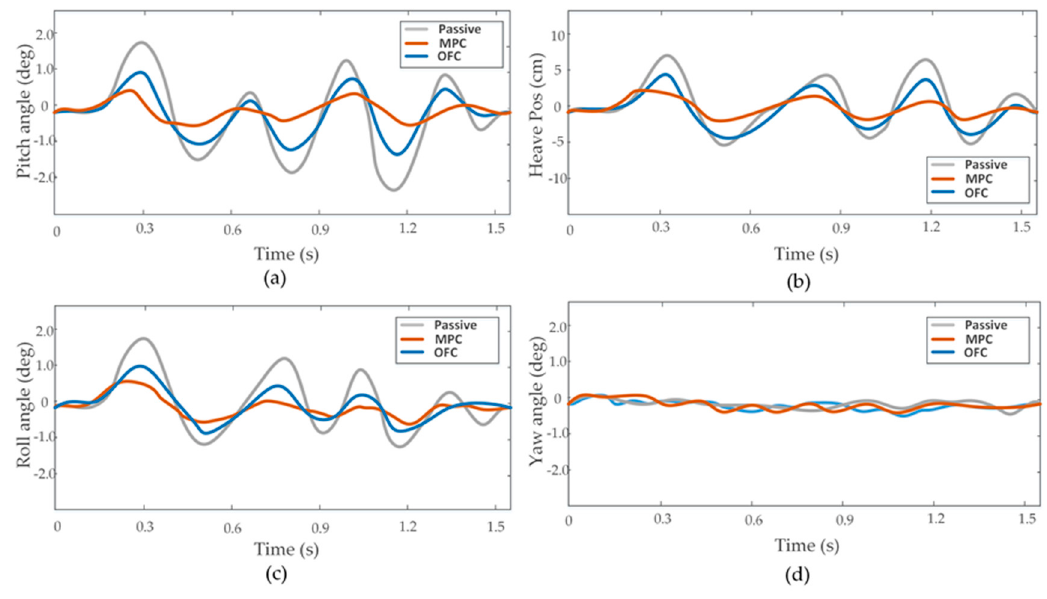
Figure 8. Time domain plots of heave, pitch, roll, and yaw data obtained by sensors. ( a ) Pitch angle.